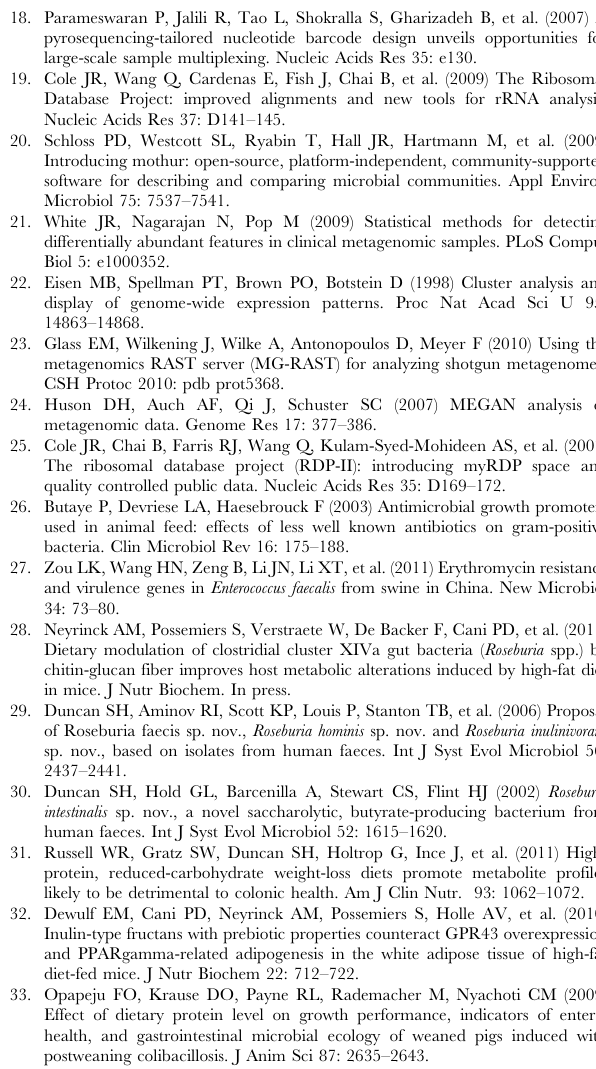
Table S2 Most abundant OTUs with significant changes in response to anticoccidial/growth promoter treat- ment. See Fig. 5 for description of